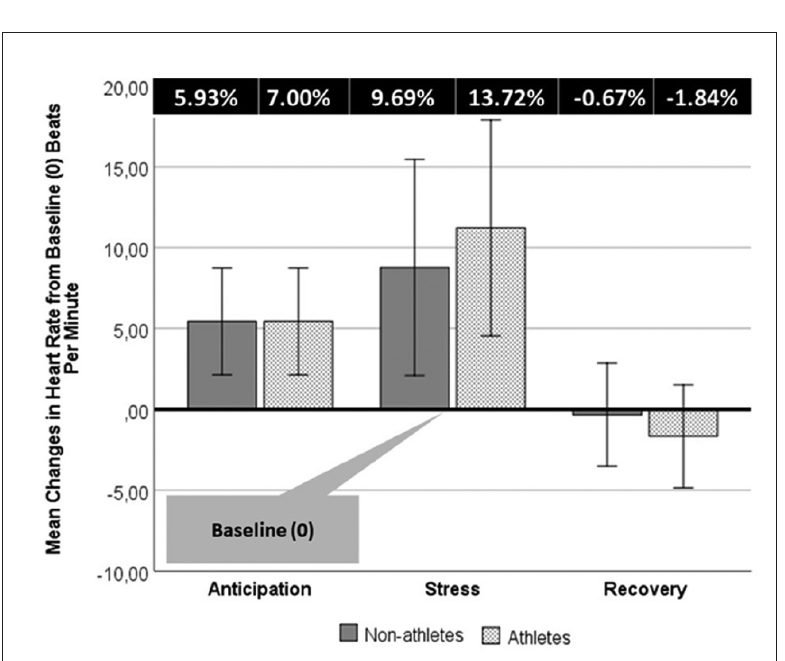
Note. Error bars represent the 95% confidence intervals.